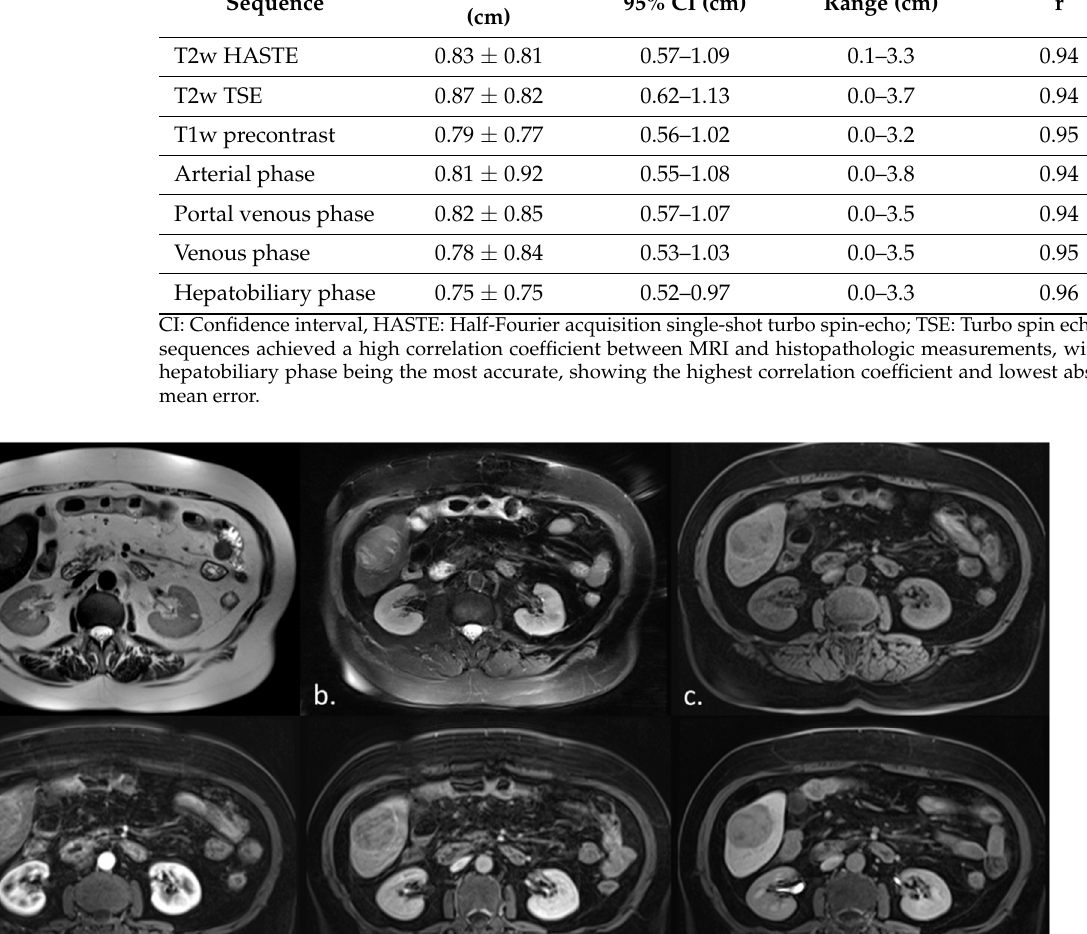
Table 4. Absolute error and Pearson correlation coefficient (r) between MRI and histopathologic measurements.